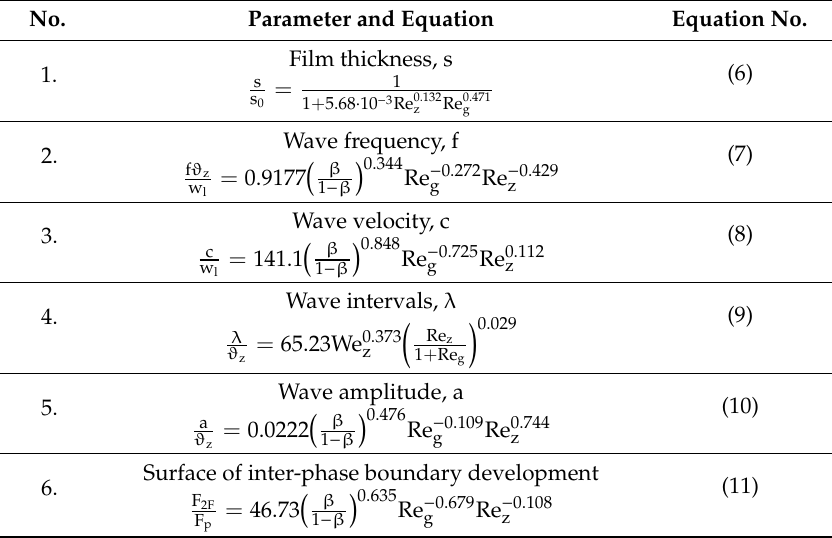
Table 1. Reference methods applied for calculation of parameters of two-phase gas–very viscous liquid flow